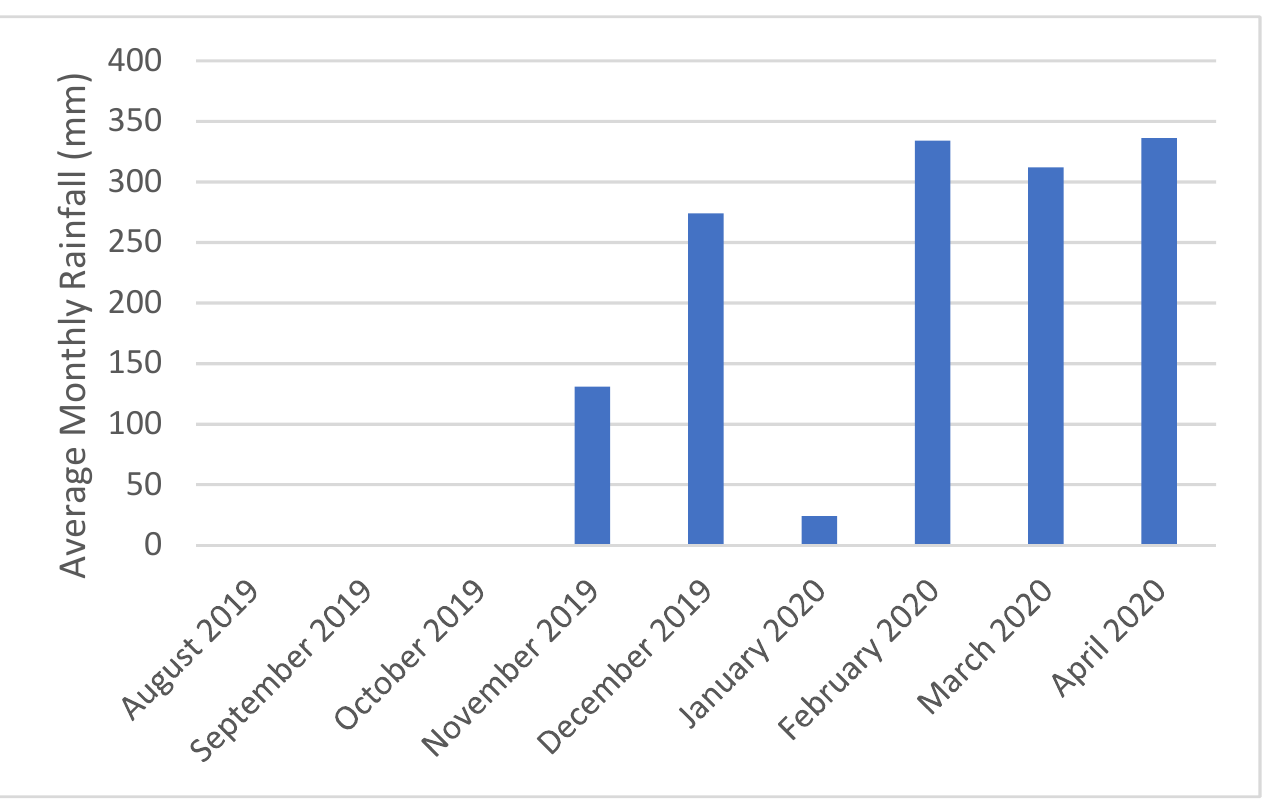
Figure 1. Average monthly rainfall in Gunungkidul, Yogyakarta, Indonesia, 2019–2020. Gunungkidul is one of the specific karst areas on the southern coast of Java Island.